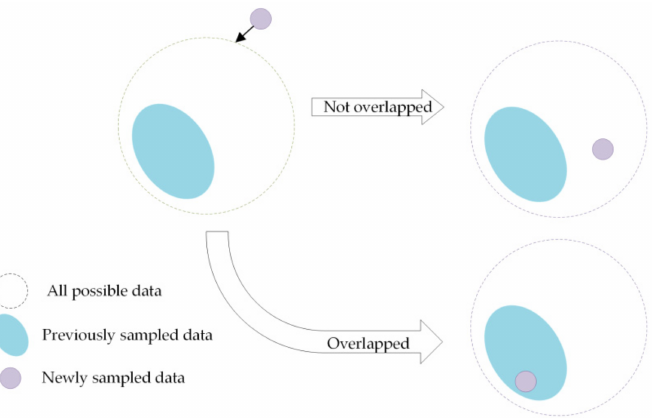
Figure 8. Two cases of adding new samples to dataset. In the first case, the new sample does not overlap with the previously sampled data. In the second case, the new sample overlaps with the previously sampled